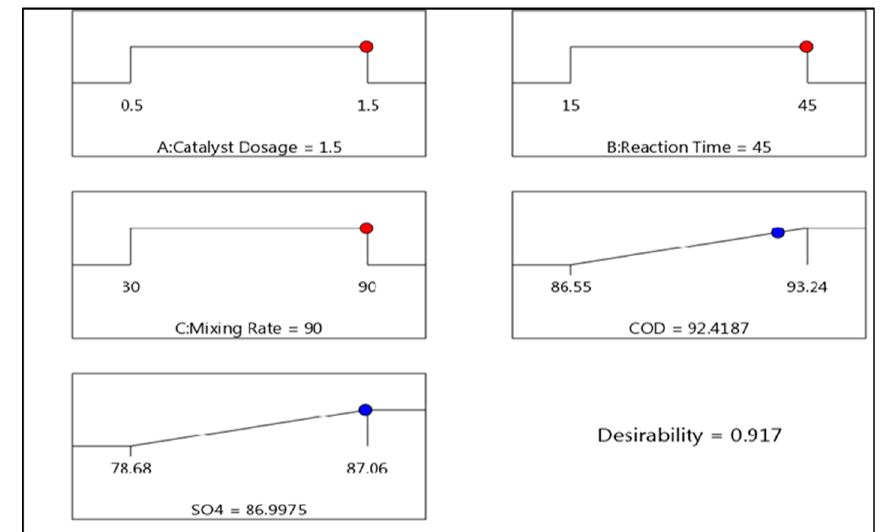
Figure 8. Optimum operating conditions for